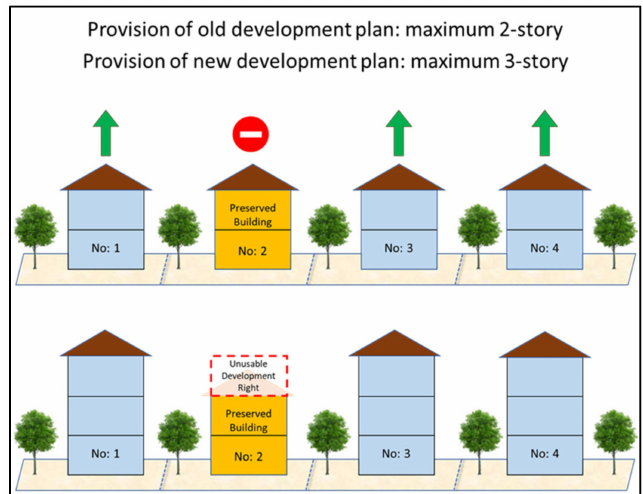
Figure 2. Unequal effects of